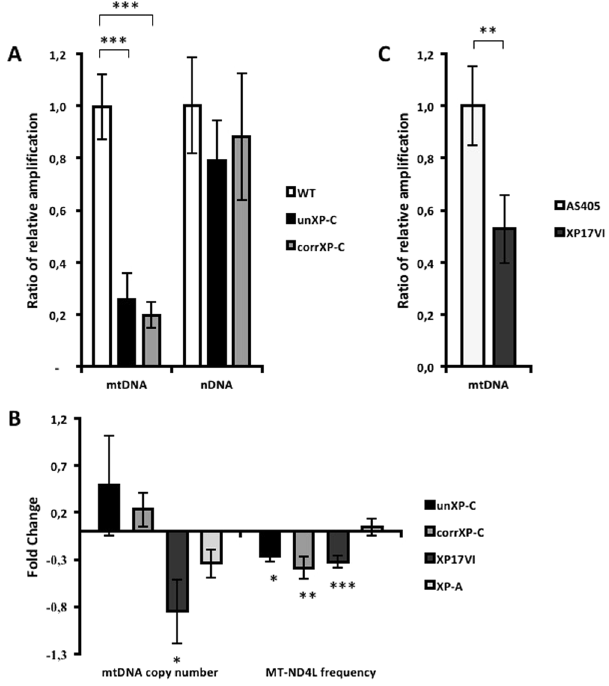
Figure 5. Accumulation of DNA damage in mtDNA in XP-C cells. DNA damage was measured by XL-PCR amplification of a 16.3 kbp fragment of the mtDNA ( A , left , and C ) and a 10.4 kbp fragment of the HPRT gene, for the nuclear genome ( A , right ). Data is presented as ratio of bands intensity of long fragment over small fragment loading control ( MT-ND1 and HPRT to mt and nDNA, respectively) relative to WT. The data represent mean ± SD in transformed and primary cells (n = 3). ( B ) MtDNA copy number and MT-ND4L frequency was assessed as the relative amplification of MT-ND1 (mtDNA gene) and HPRT (nDNA gene), and of MT-ND4L gene (frequently deleted) vs. MT-ND1 gene (rarely deleted), as described. WT and AS405 gene expression fold change are implicit and were set to 0.0 (zero) as control reference. The data represent mean ± SD in transformed (WT, unXP-C, corrXP-C and XP-A, n = 4) and primary (AS405 and XP17VI, n = 4 and n = 6, respectively) cells * p < 0.05, ** p < 0.01 and *** p <